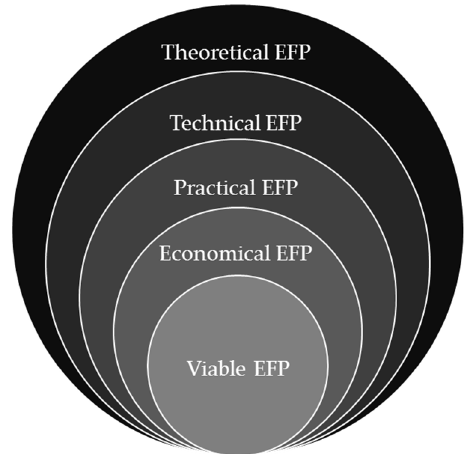
Figure 3. Types of energy flexibility potential based on different quantification reference frameworks. (Adapted from Reference [25], own illustration).